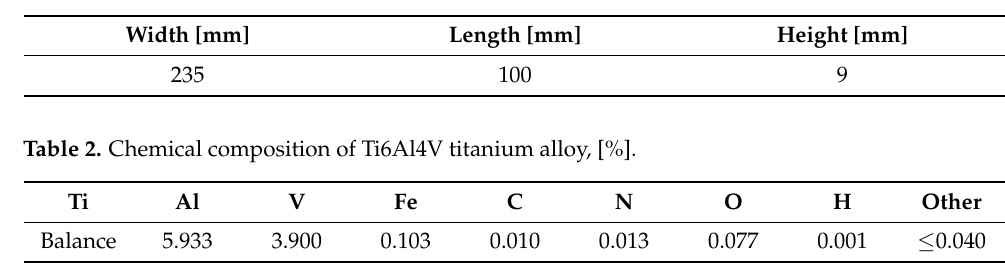
Table 1. Workpiece dimensions.